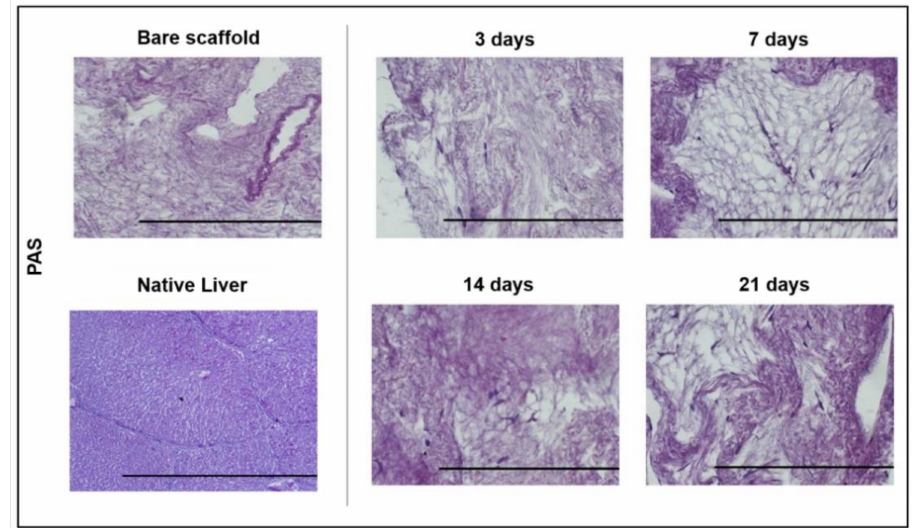
Figure 6. Functional evaluation of pMSC seeded on ECM scaffolds. PAS staining was used to identify glycogen. No deposits of glycogen/polysaccharides that should result in pink/red were observed at the four different time points after PAS staining. In the figure, cells/ECM resulted in dark purple. PAS staining of the native liver is also reported for comparison. (Magnification 40 × , scale bar: 200 µ m for